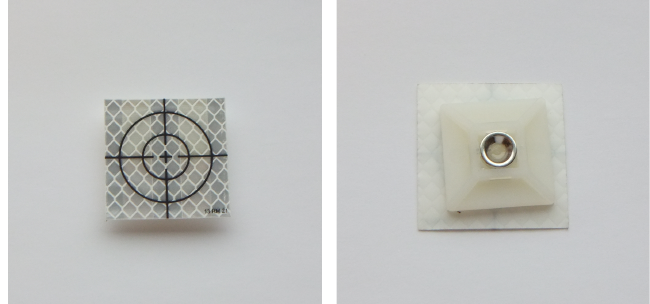
Figure 10. A marker used by subjects to designate the IR targets in the working area. Left: front side. Right: back side.